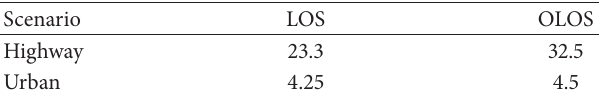
Table 3: Decorrelation distances 𝑑 𝑐 for highway and urban scenar- ios.